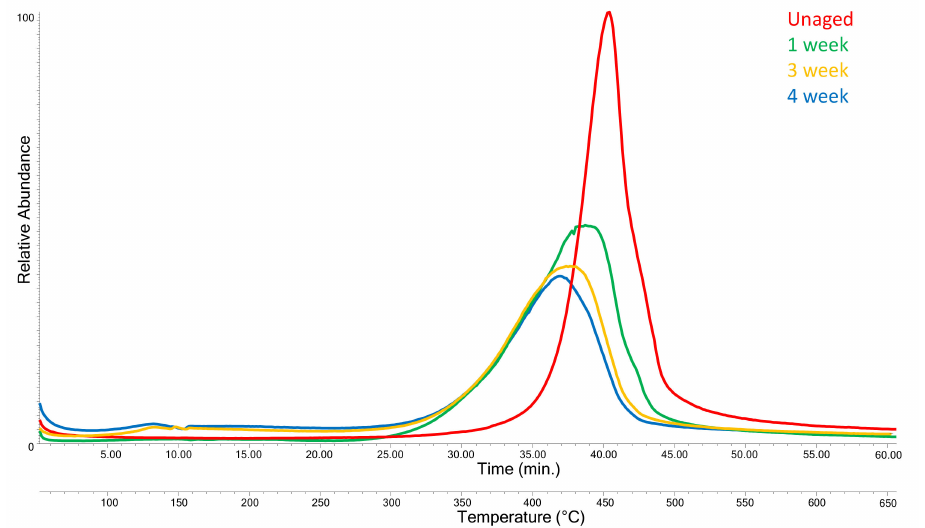
Figure 3. Evolved gas analysis (EGA) profiles of polypropylene (PP) after different artificial aging times: PP-0w (red), PP-1w (green), PP-3w (yellow), and PP-4w (blue) accelerated